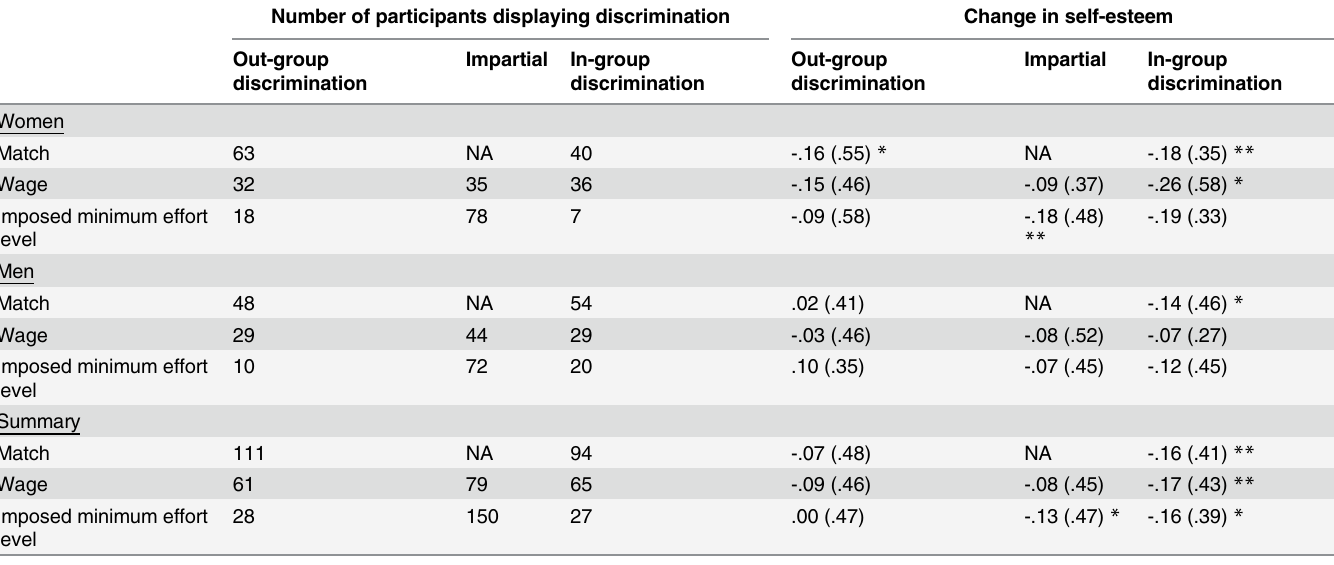
Table 3. Sex-based discrimination: Frequency of discrimination, and changes in self-esteem according to discrimination. Number of participants displaying